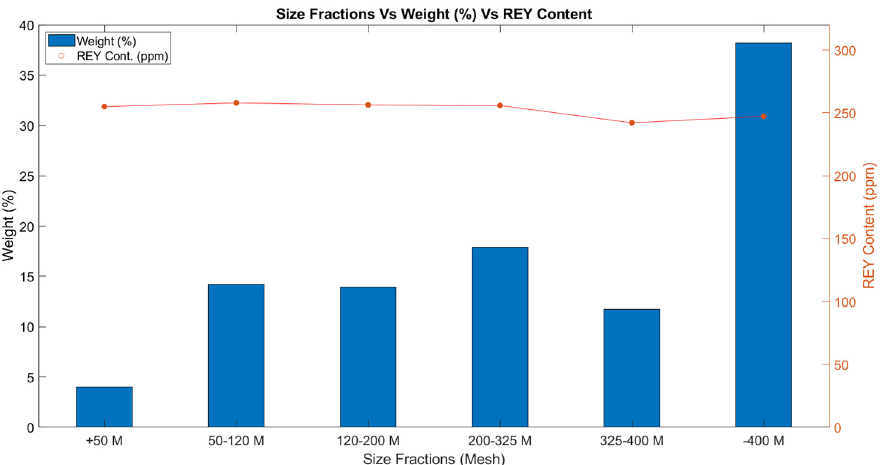
Figure 4. REY content of the various size fractions.